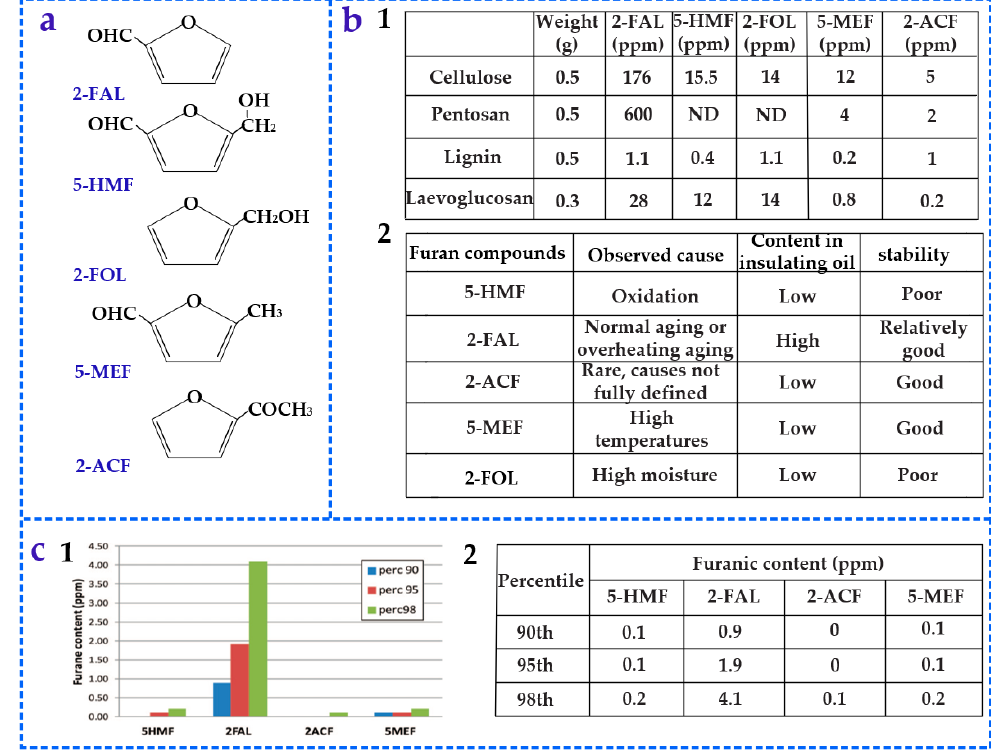
Figure 4. The structure characteristics of furan compounds from cellulose degradation and the measured results in transformer oil are summarized.